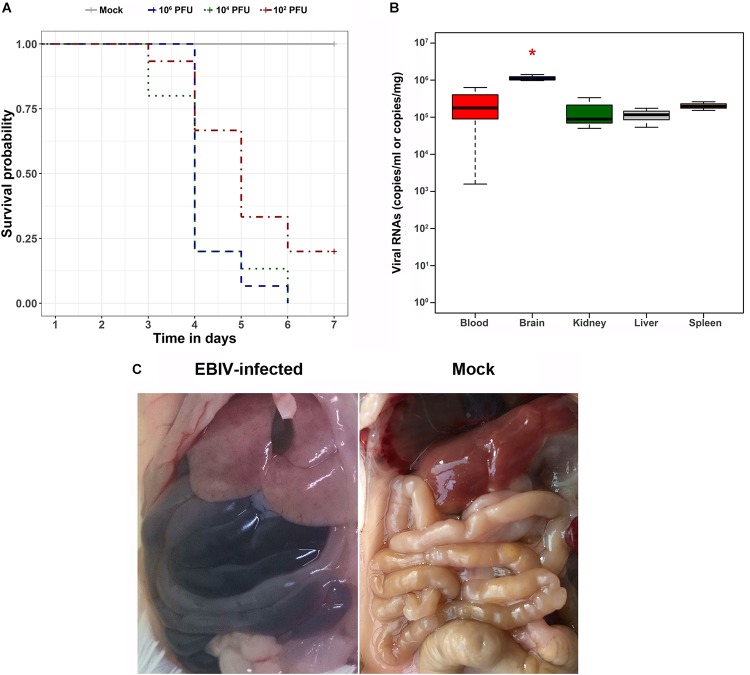
Survival analysis, viral RNA detection in tissues, and gross pathology findings of EBIV-challenged mice. (A) Survival curve of mice challenged with serial dilutions of EBIV. Adult mice (n = 5 per group, replicated three times) were challenged intraperitoneally with 106 PFU (dark blue), 104 PFU (dark green), and 102 PFU (dark red) of EBIV. (B) The viral RNA copies in blood, brain, kidney, liver, and spleen tissues were detected by quantitative RT-PCR, and the brain tissue presented a significant difference (*P < 0.05) compared to the other tested tissues. (C)
In situ picture of organs in EBIV-infected animals with hemorrhaging and mock-infected animals.